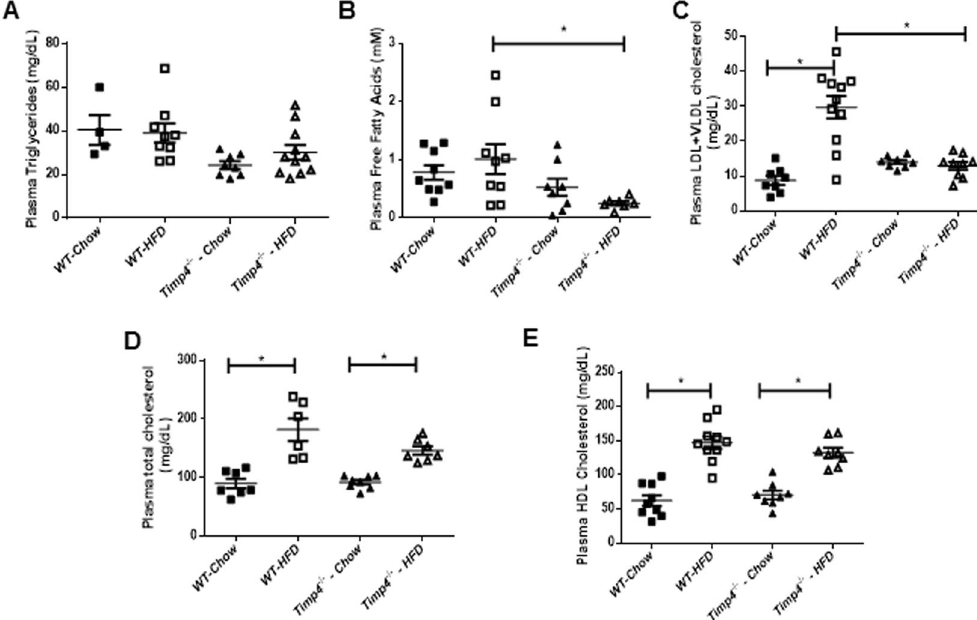
Figure 5. Timp4 − / − mice show protection against HFD-induced elevations in plasma free fatty acids and LDL-cholesterol. Fasting plasma triglyceride (TG) ( A ), free fatty acids ( B ), LDL and VLDL cholesterol ( C ), total cholesterol ( D ) and HDL cholesterol levels ( E ) in indicated groups. Averaged data are presented as mean ± S.E.M and analyzed by ANOVA. * indicates significance (p <